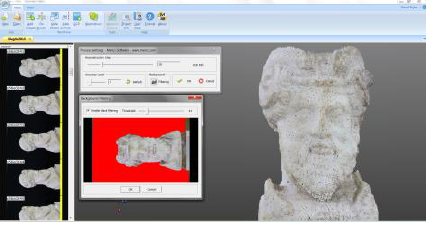
Figure 5. Menci-Umap-Masking and point cloud model